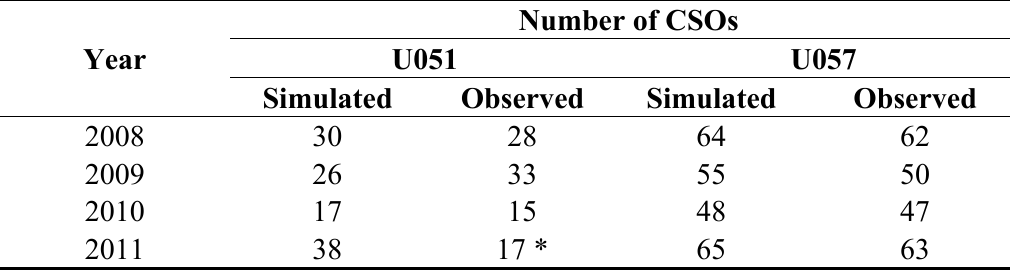
Table 9. Comparison of the number of simulated CSOs with the number of observed CSOs for the 1 May to 30 September period.